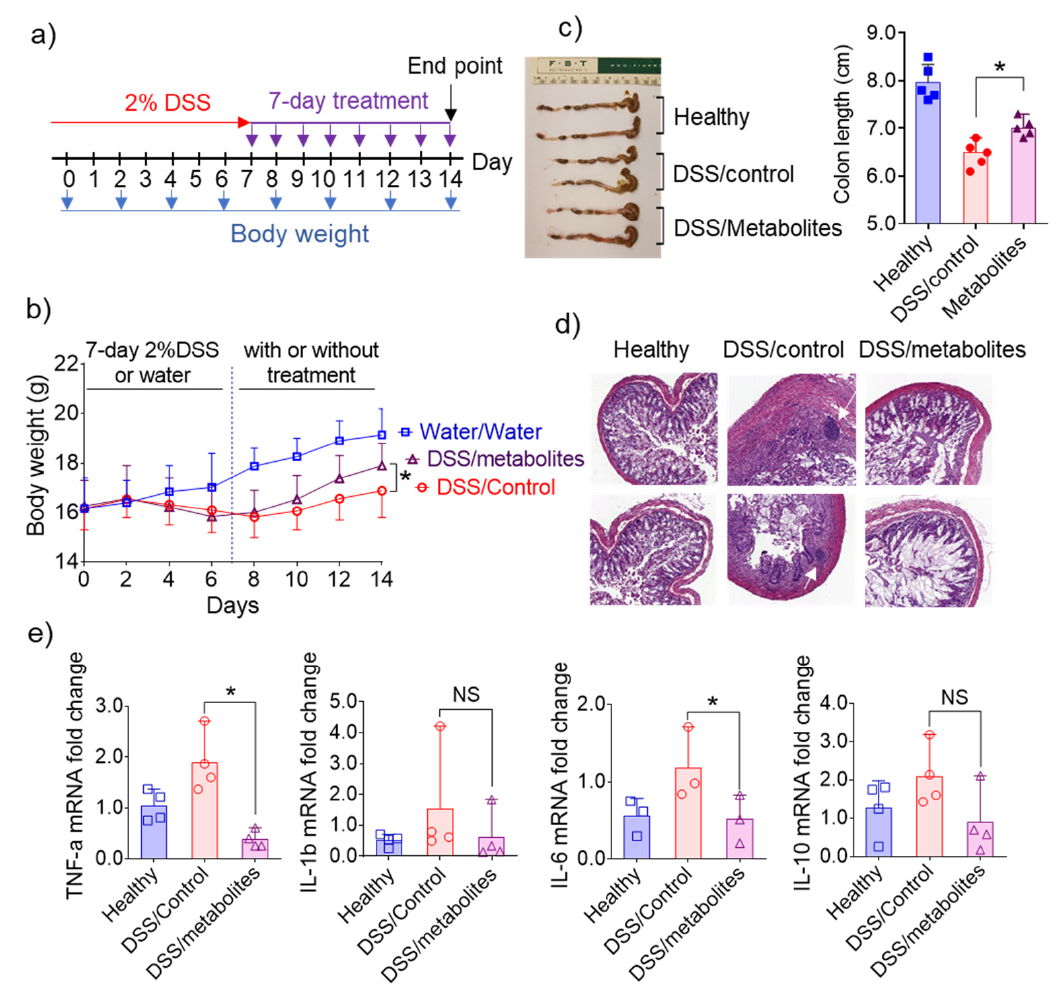
Figure 6. Effects of microbiota-derived metabolites from 6S/nLNP-treated mice in an in vivo wound-healing model. ( a ) Schematic diagram showing treatment and feces collection. ( b ) Body weight changes in control mice (water only; gray) and mice treated for seven days with 2% DSS, followed by seven days of microbiota-derived metabolites from 6S/nLNP-treated mice (purple) or seven days of normal microbiota-derived metabolites (red) ( n = 5; * p < 0.05). ( c ) Colon lengths in each group of mice ( n = 5; * p < 0.05). ( d ) H&E-staining. White arrows indicate inflammatory cells in the lamina propria. ( e ) Measurement of mRNA levels of cytokines in the DSS-induced mouse model of wound healing ( n = 4; * p < 0.05, NS: non-significant).